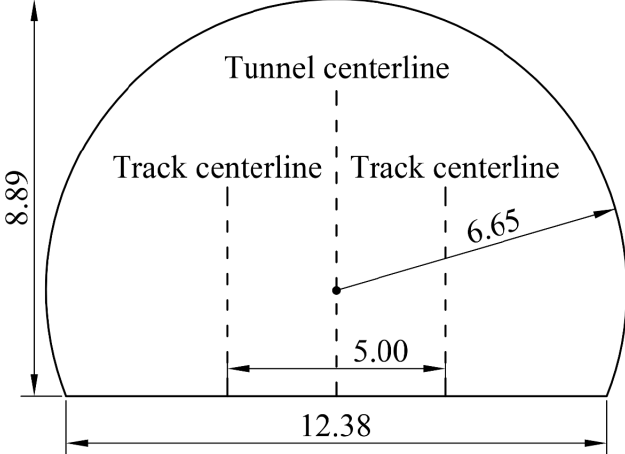
Figure 1. Configuration of tunnel (unit: m).